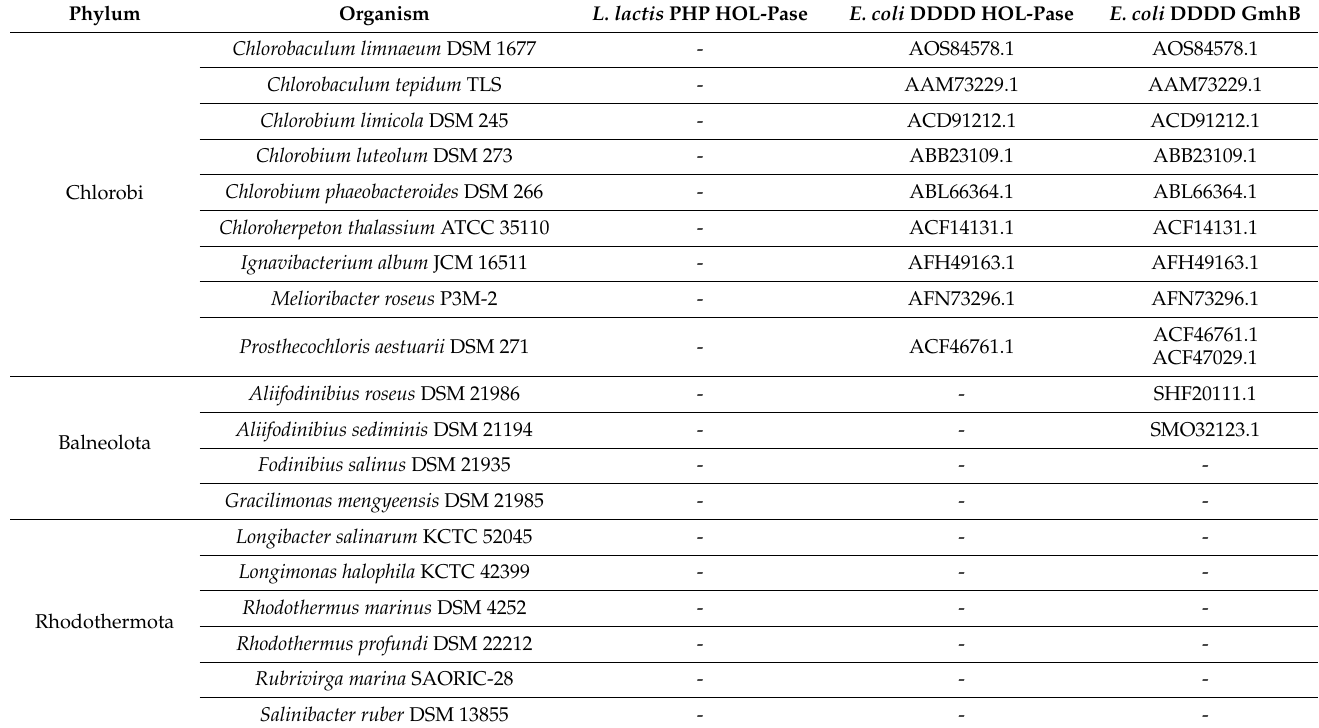
Table 2. L. lactis PHP HOL-Pase, E. coli DDDD HOL-Pase, and E. coli DDDD GmhB were used as queries to search for an HisN candidate in Chlorobi, Balneolota, and Rhodothermota genomes using BLASTp. For those organisms for which a phosphatase was found, the NCBI accession number of the enzyme is reported.